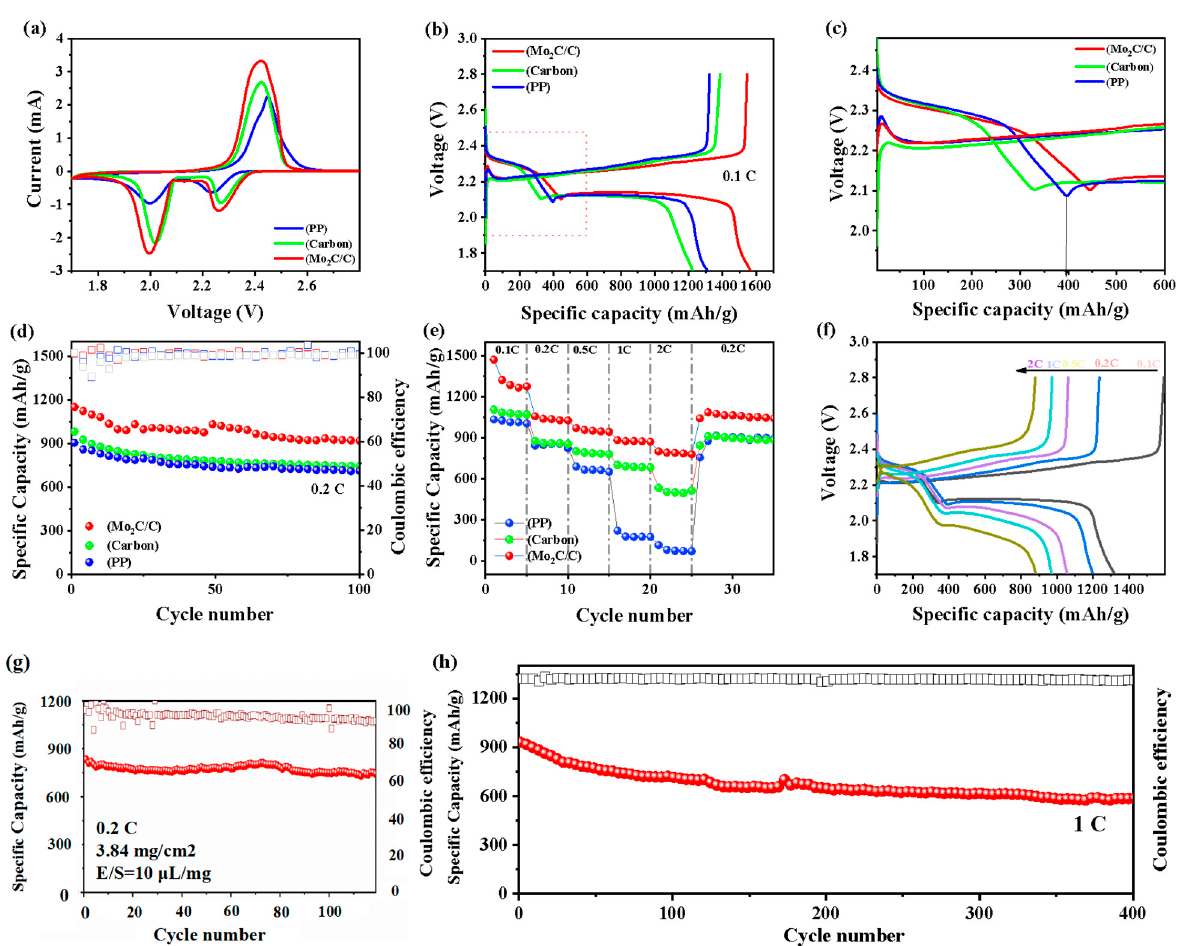
Figure 5. ( a ) First CV curves of different separators at 0.1 mV s − 1 . ( b ) Galvanostatic charge–discharge curves of different separators at 0.1 C. ( c ) The details of the charge–discharge curves at 0.1 C. ( d ) Cycling performance of different separators at 0.2 C. ( e ) Rate capabilities of different separators. ( f ) Charge–discharge curves corresponding to different rates. ( g ) Cycling performance of the Mo 2 C/C separator under sulfur loading of 3.84 mg cm − 2 . ( h ) Long cycle performance of the Mo 2 C/C separator at 1 C.